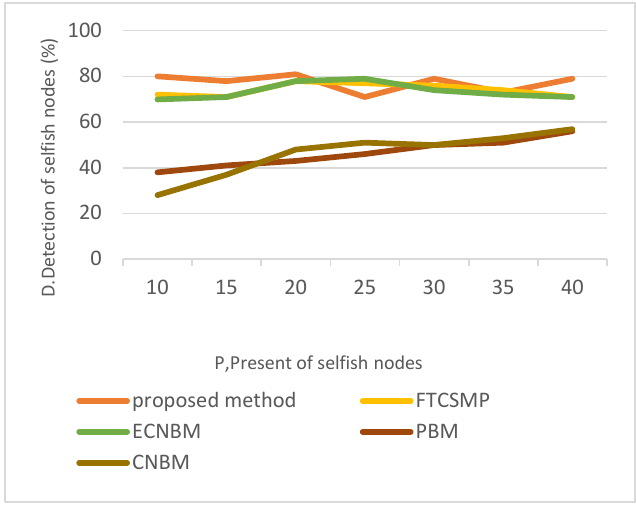
Fig. 5. Selfish node detection.